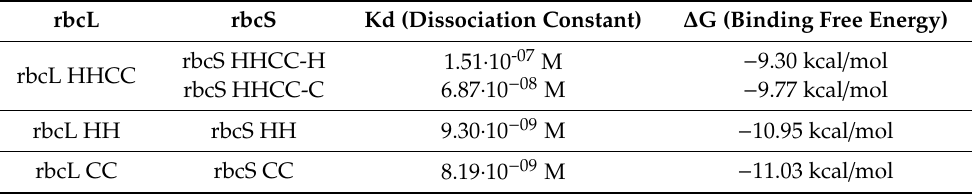
Table 2. Prediction of the binding a ffi nity of protein –protein complex of rbcL and rbcS. rbcL rbcS Kd (Dissociation Constant) ∆ G (Binding Free Energy) rbcL HHCC